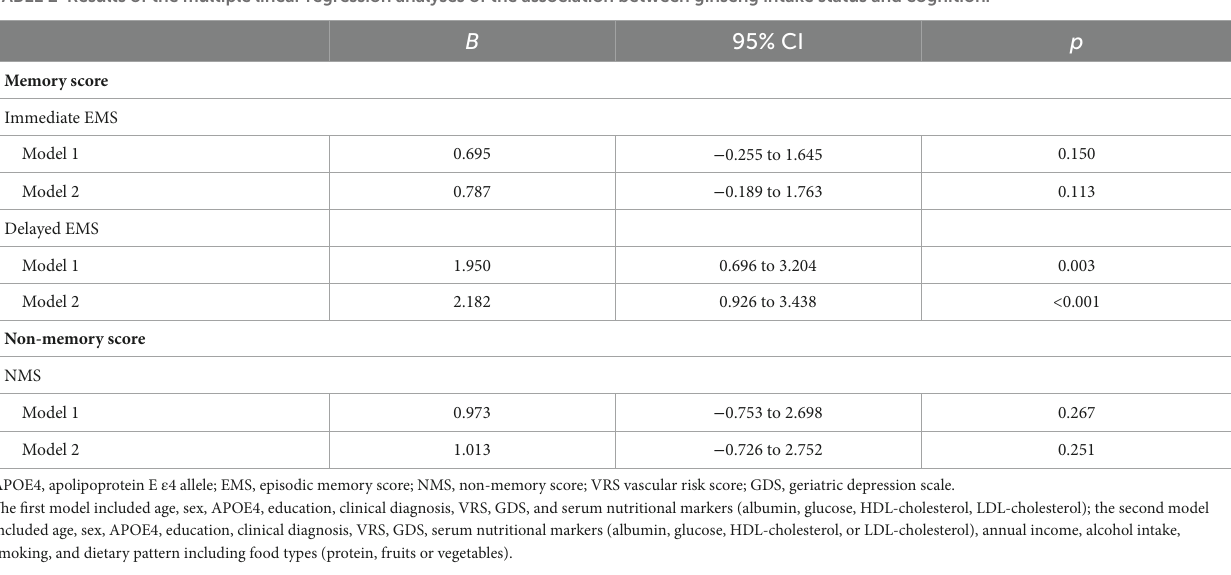
TABLE 2 Results of the multiple linear regression analyses of the association between ginseng intake status and cognition.